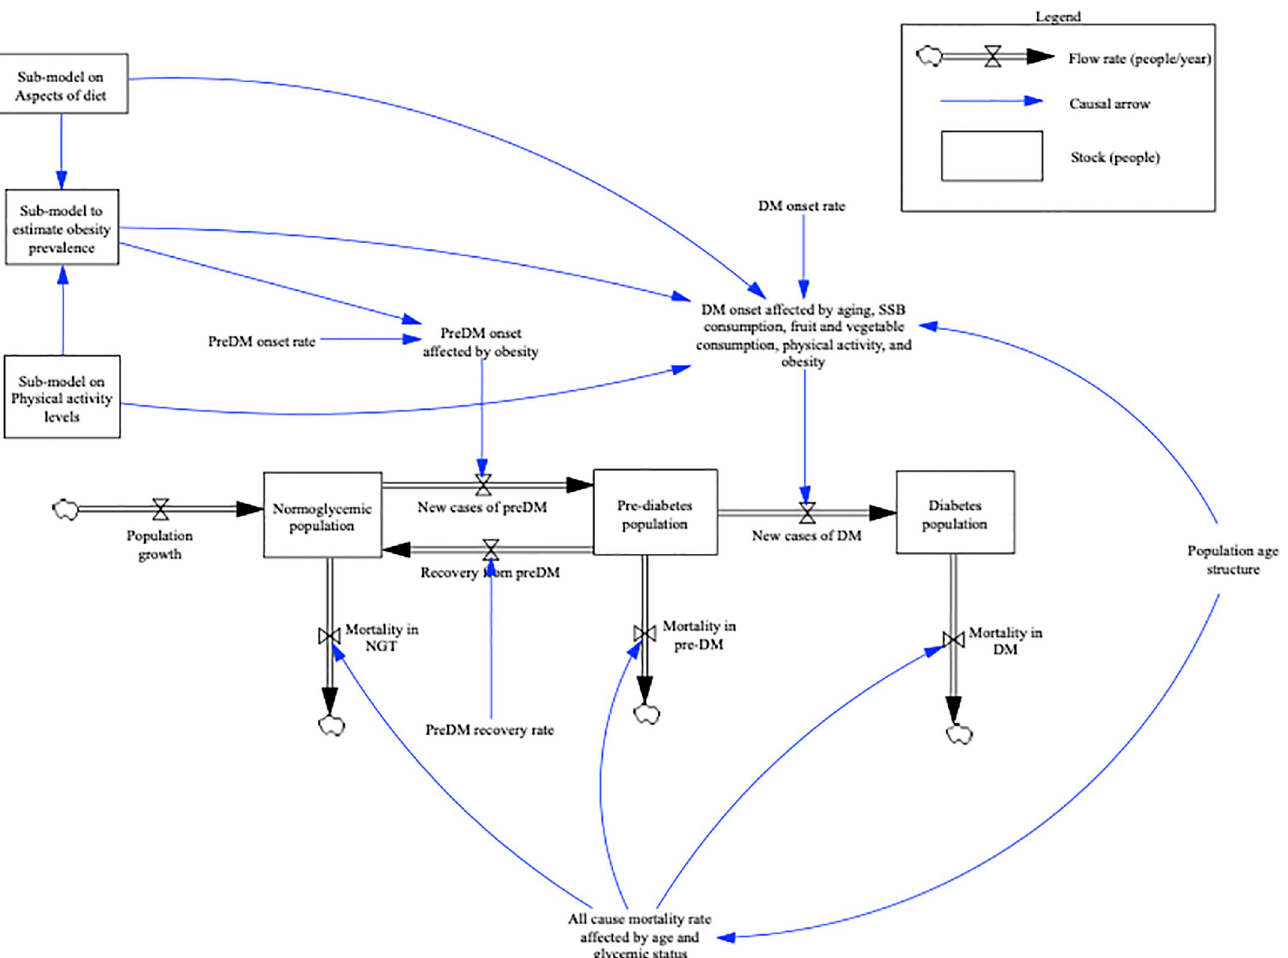
Fig 1. Summary stock and flow diagram of the core structure of the model for diabetes in the